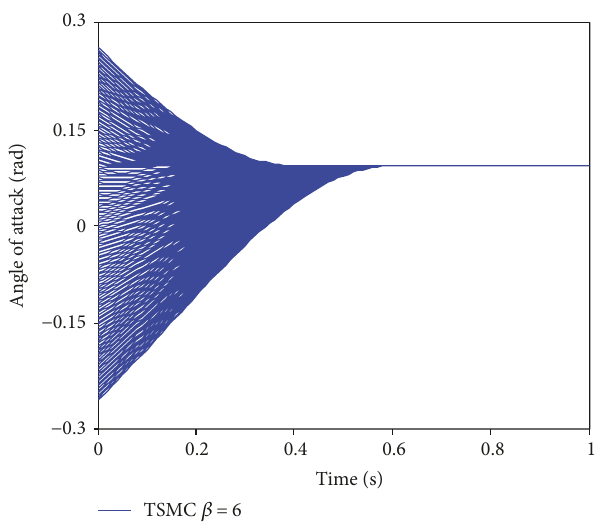
Figure 4: System response with TSMC